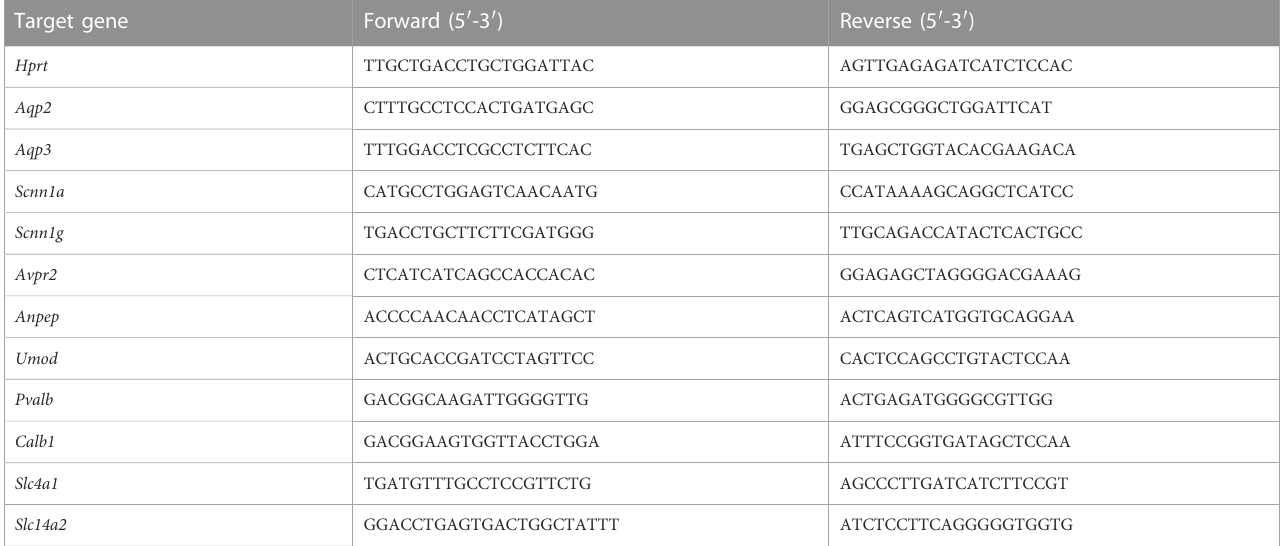
TABLE 2 Primers. Target